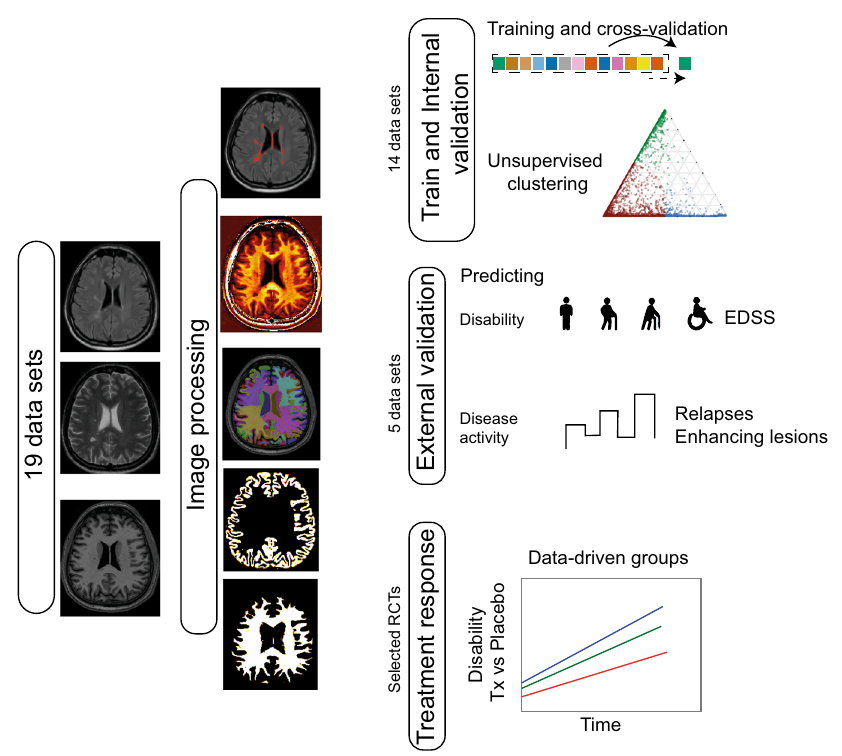
Fig. 7 Model development and validation. We processed MRI with a uniform processing pipeline. We trained the model using 14 data sets, and applied the trained model on fi ve independent, unseen data sets for validation. We demonstrated if MRI-based subtyping at baseline, could predict EDSS progression and disease activity. In selected RCTs, from RRMS and progressive (SP and PP MS), we looked at if MRI-based subtyping could predict treatment response. EDSS expanded disability status scale, RCT randomised controlled trial, Tx treatment, PASAT paced auditory serial addition